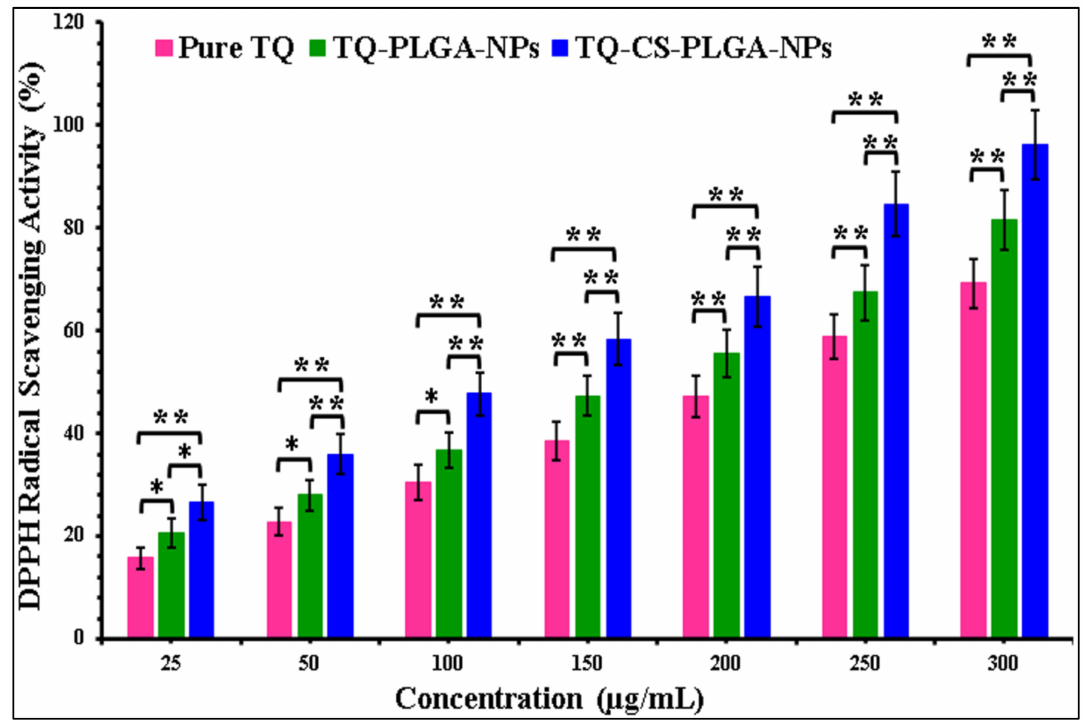
Figure 7. Comparative antioxidant activity of TQ-CS-PLGA-NPs, TQ-PLGA-NPs, and pure thymoquinone (TQ). Results are expressed as percentage mean ± SD ( n = 3). * and ** represent significant and highly significant difference to different